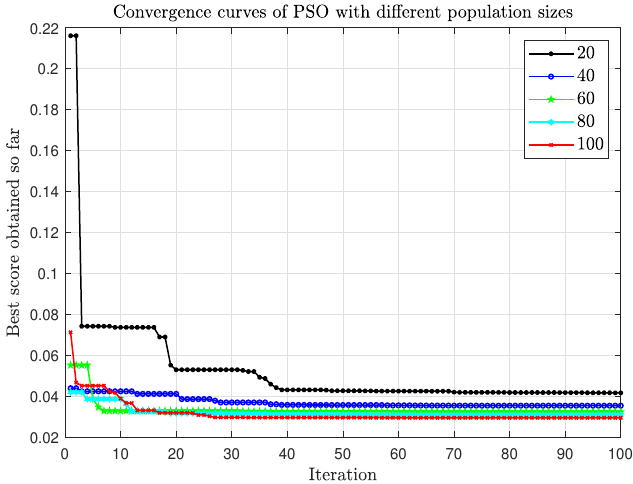
Figure 4. Convergence curves of PSO using various numbers of population